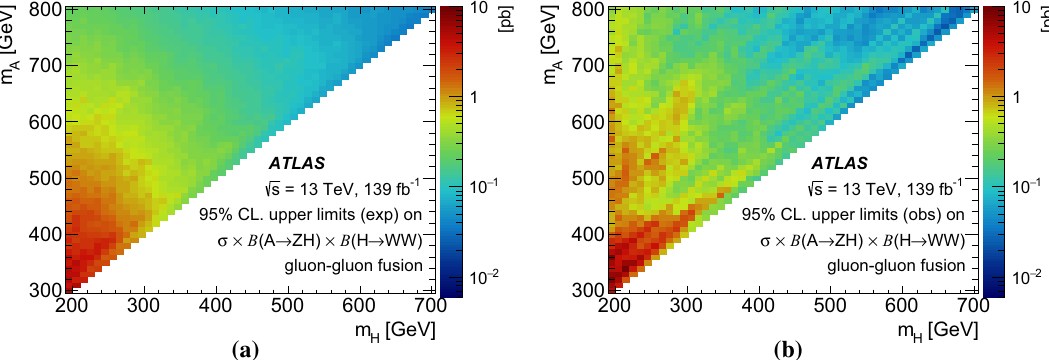
Fig. 13 Expected ( a ) and observed ( b ) upper bounds at 95% CL on the production cross section times the branching ratio B ( A → Z H ) × B ( H → WW ) in